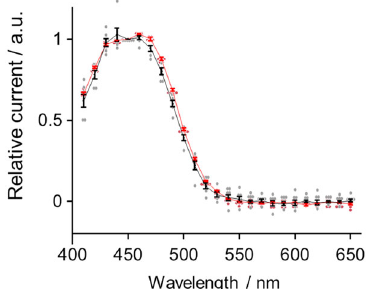
Fig. 4 Action spectrum of KnChR-272 and KnChR97. Wavelength dependency of the photocurrent. The photocurrents were measured in standard solutions. The membrane voltage was clamped at − 40 mV. Red, KnChR-272 ( N = 5), Black, KnChR-397 ( N = 6). Data were presented as the mean ±